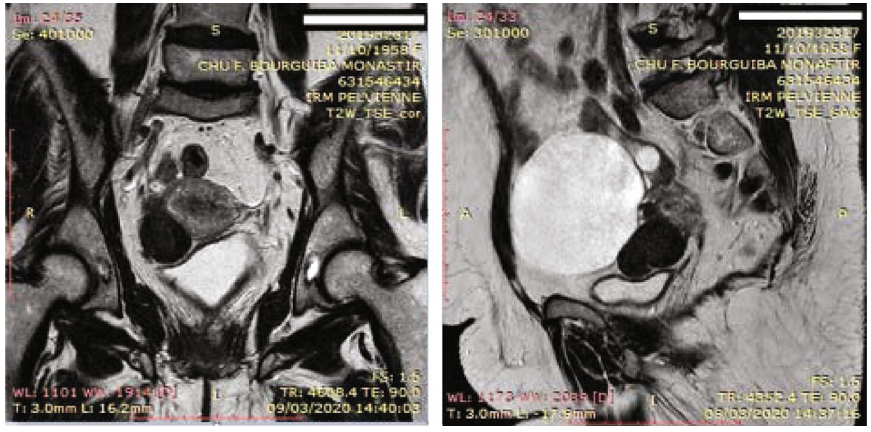
Figure 1: MRI aspect of the